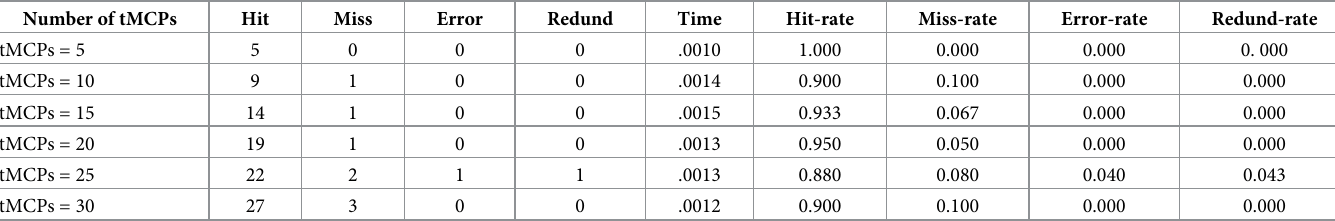
Table 5. The results of MCPs detection as the t MCPs ranged from 5 to 30 in the RSW&TST framework. Number of